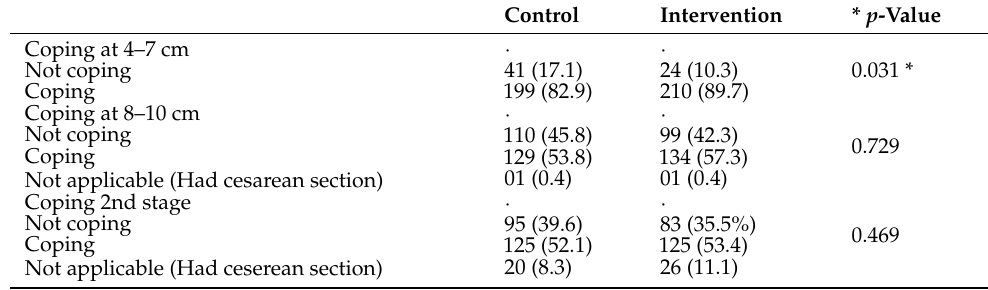
Table 4. Proportions of women coping during different phases of labor.